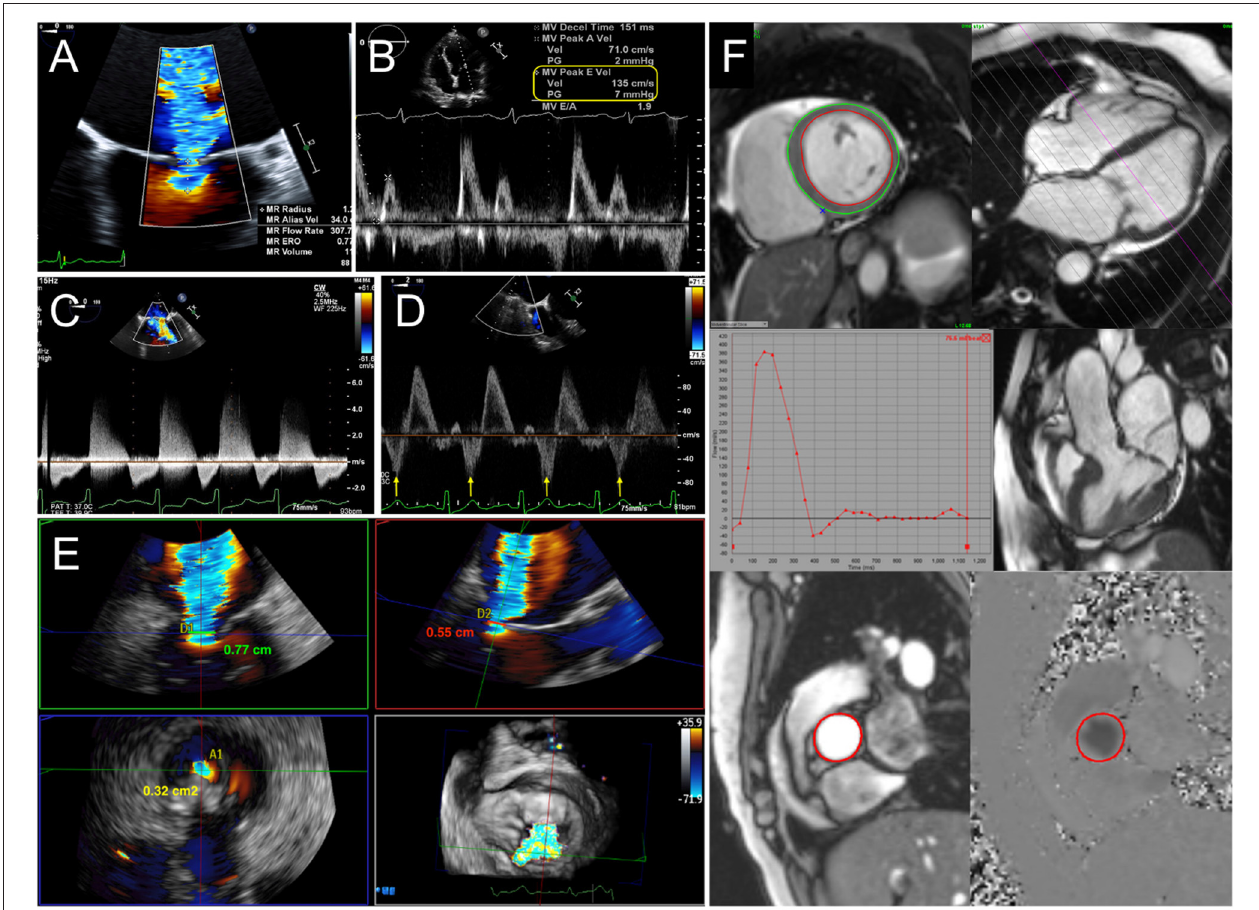
FIGURE 1 | Quantification of mitral regurgitation (MR). (A) Calculation of effective regurgitant orifice area (EROA) and regurgitant volume (RVol) by proximal isovelocity surface area (PISA) method. Indicators for severe MR include elevated early diastolic mitral inflow (E wave) velocity (B) , dense continuous-wave Doppler signal (C) , and systolic reversal of pulmonary vein flow (D) . (E) 3D vena contracta area reconciles discrepant linear vena contracta width measurements in an elliptical regurgitant orifice. (F) With cardiac MRI, mitral RVol is calculated as the difference between total left ventricular stroke volume and the aortic flow (forward stroke volume) by phase-contrast